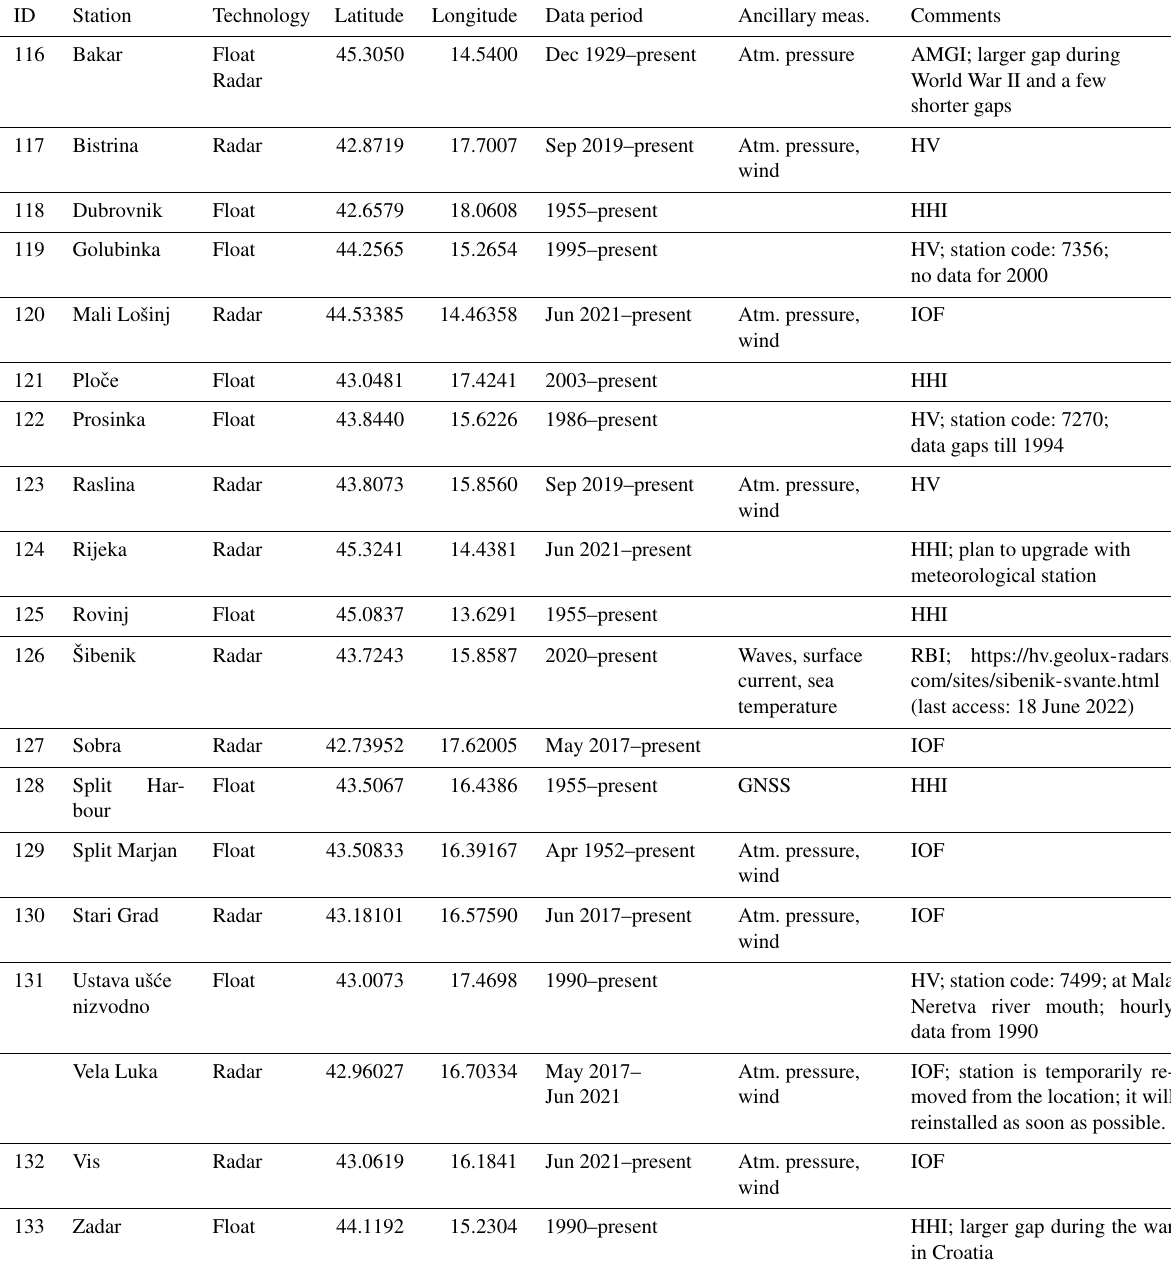
Table A12. Croatian tide gauge stations operated by the Andrija Mohoroviˇci´c Geophysical Institute (AMGI), Hrvatske Vode (HV), Hydro- graphic Institute of the Republic of Croatia (HHI), Institute of Oceanography and Fisheries (IOF), and Ru¯der Boškovi´c Institute (RBI).